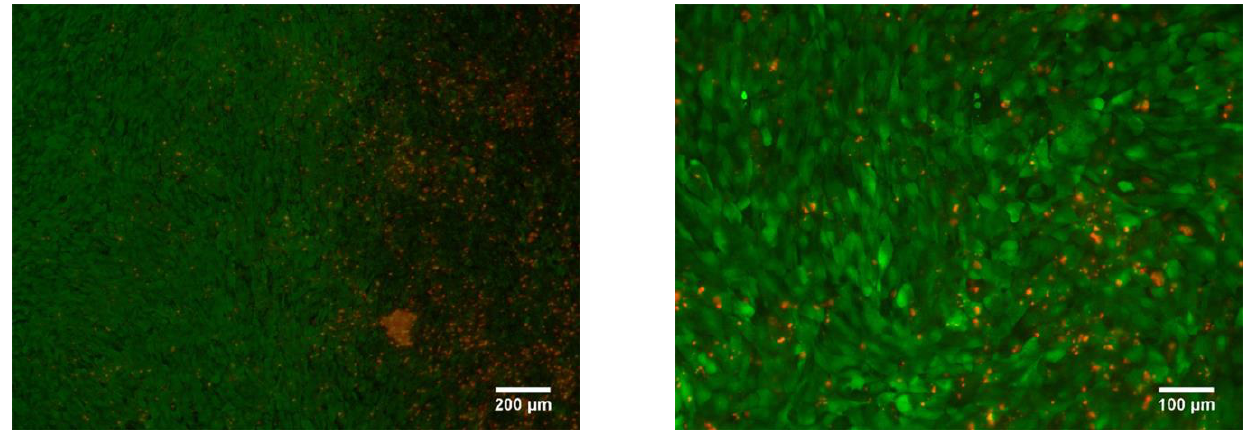
Figure 20. Porous Ti-Nb sample LIVE/DEAD stained with Calcein AM/PI after 7 days of incubation.